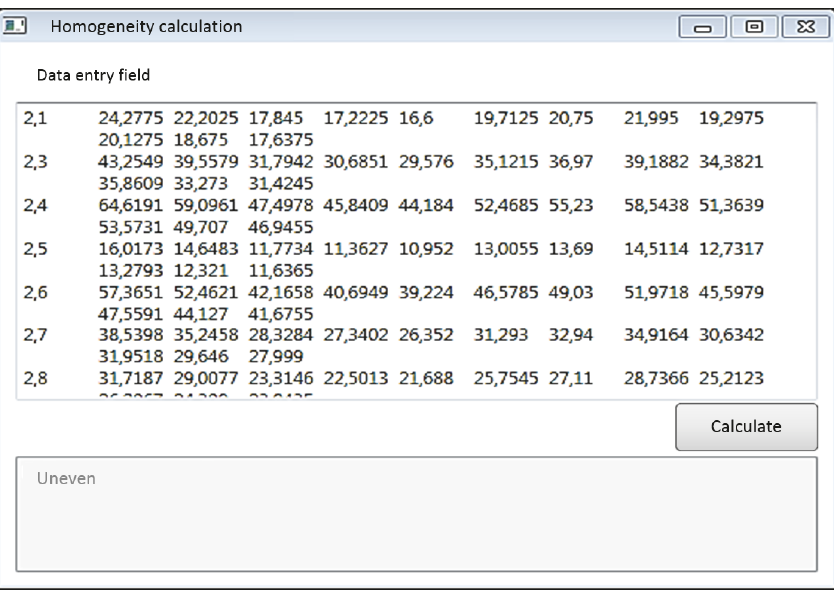
Figure 4: Example of calculations in the